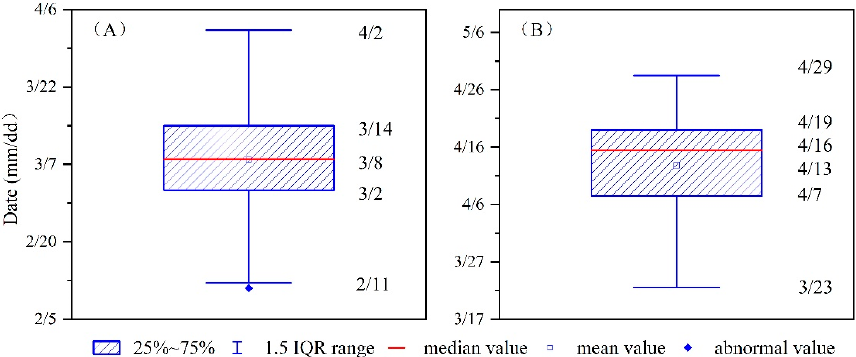
Figure 3. Dates of the minimum snowmelt factor ( A ) and maximum snowmelt factor ( B